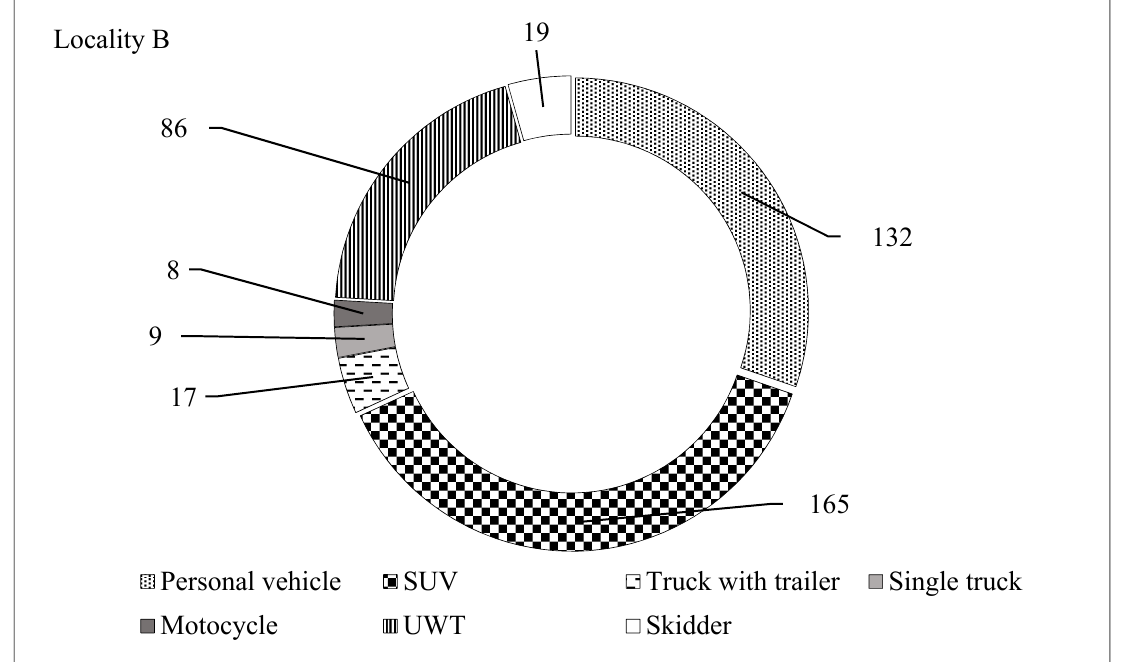
Figure 7. Absolute and relative frequencies of passages of individual vehicle types at B locality in the year 2020.